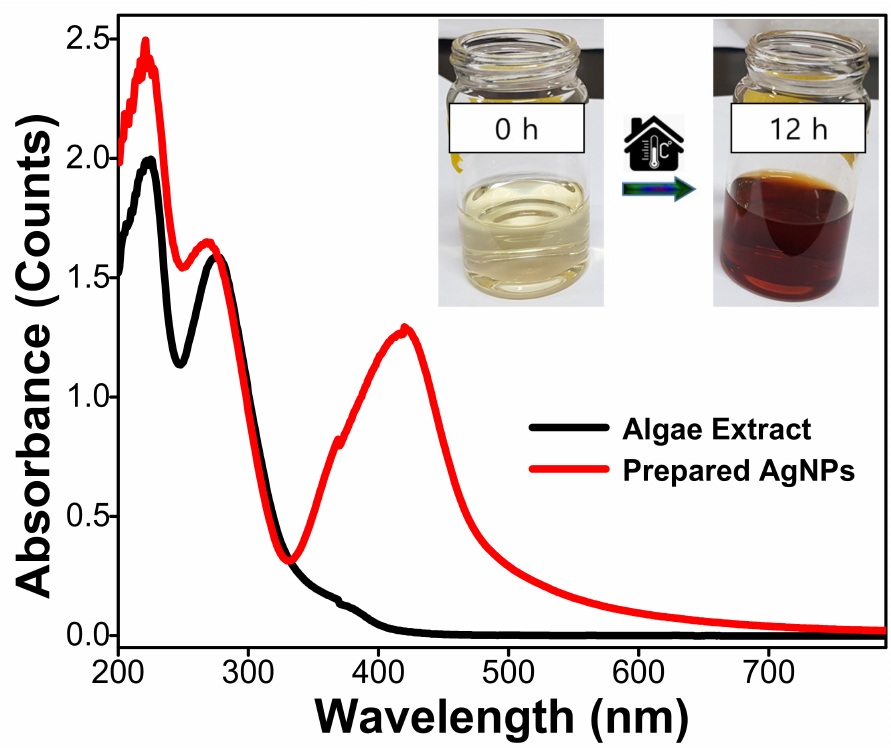
Figure 1. UV-vis spectra of algae extract and prepared Ag